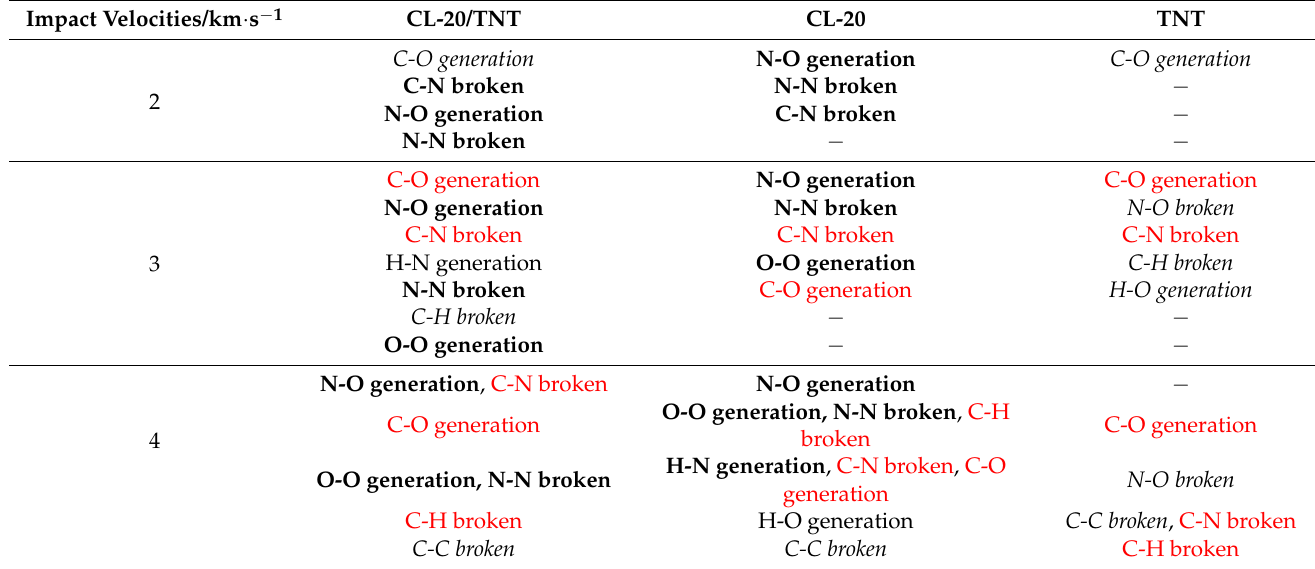
Table 4. Initial changes of the chemical bond types in the CL-20/TNT, CL-20 and TNT crystals at di ff erent impact velocities *. Impact Velocities CL-20/TNT CL-20 TNT